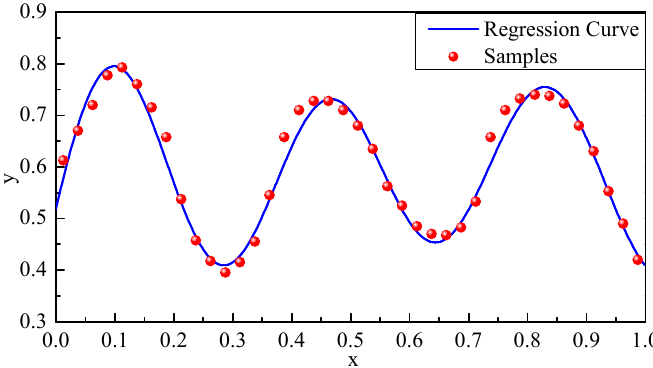
Figure 5. Sample regression diagram.